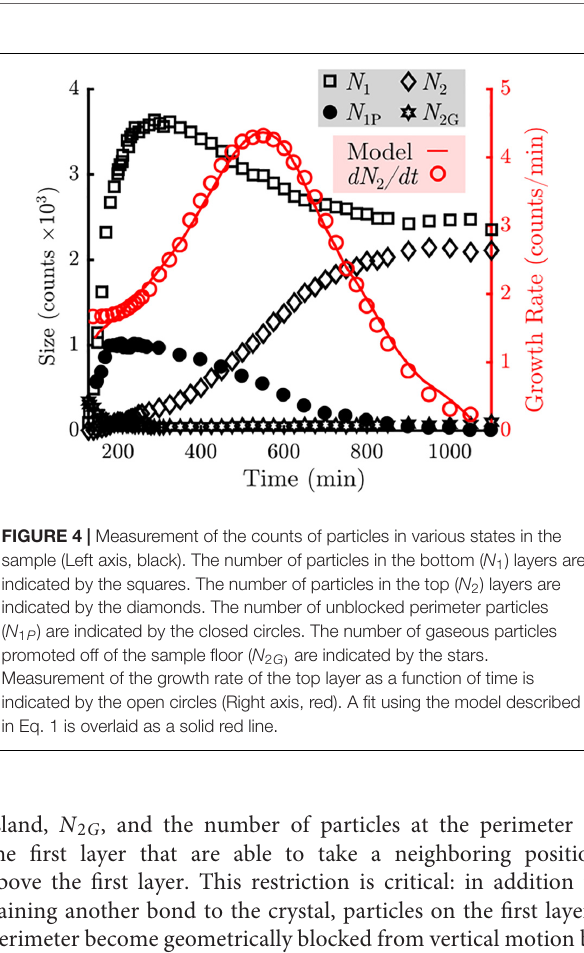
FIGURE 3 | Characteristic images of crystallizing mixtures of attractive colloidal hard spheres. Dark particles reside on the glass sample chamber. White particles are in focus, about 1 µ m above the black particles. Crystals formed from panel (A) monodisperse and (B–F) bidisperse mixtures show distinctly different “final” morphologies, 20 h after initial nucleation. The monodisperse sample forms monolayer crystals, while the bidisperse sample forms bilayer crystals of small particles. To illustrate the formation of bilayer crystals in the bidisperse sample, we show one image every 400 min (scale bar = 10 µ m). (C) At 0 min, the system is a gas of bidisperse particles (scale bar = 10 µ m). (D) After 400 min, the nucleation and growth of the monolayer crystals of small particles has completed, with the larger particles displaced to the periphery of the islands. In addition, we observe the nucleation and growth of a second crystal layer as indicated by the white particles (scale bar = 10 µ m). (E) The top layers continue to grow through 800 min, while the exposed monolayer regions shrink. The large particles have formed monolayers of their own species at the crystal edges (scale bar = 10 µ m). (F) The final panel shows the final configuration of the system after 1200 min. We see that all islands throughout the sample chamber consist of two full layers (scale bar = 10 µ m). Furthermore, we find that the largest crystal island in the field of view completely melts during the transition to a two-layer system, while the smallest two-layer islands persist.